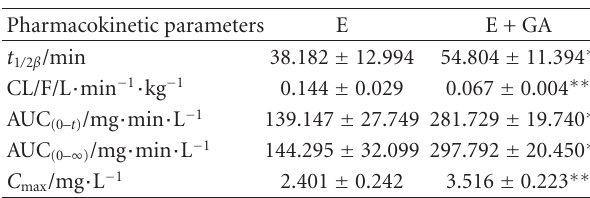
Table 1: The main pharmacokinetic parameters of cortisone in two groups n = 6.